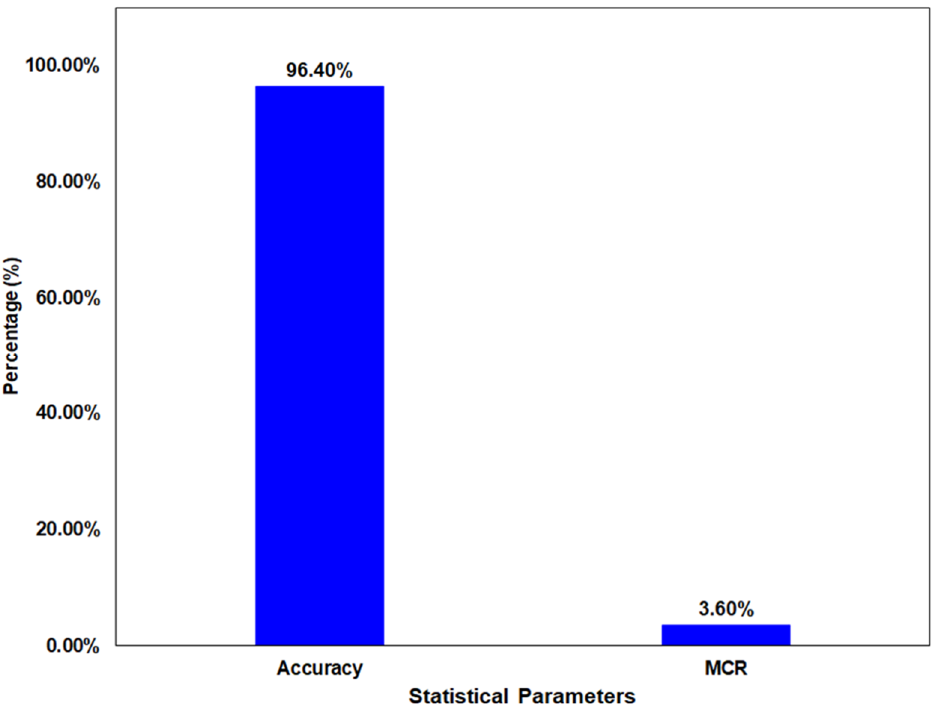
Figure 4. The overall accuracy and MCR for hydrogen storage prediction using the proposed HSPS- WFML model.